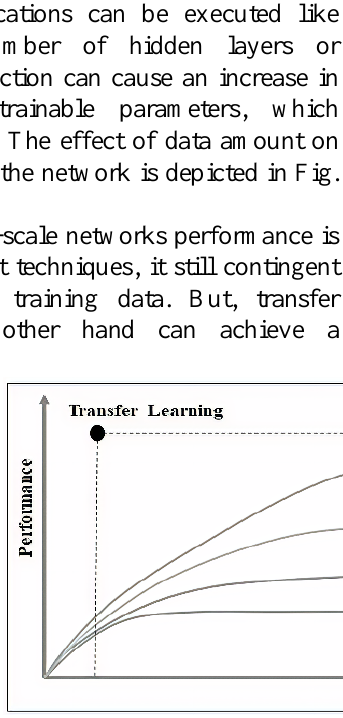
Fig. 4. Performance of learning approaches vs. data